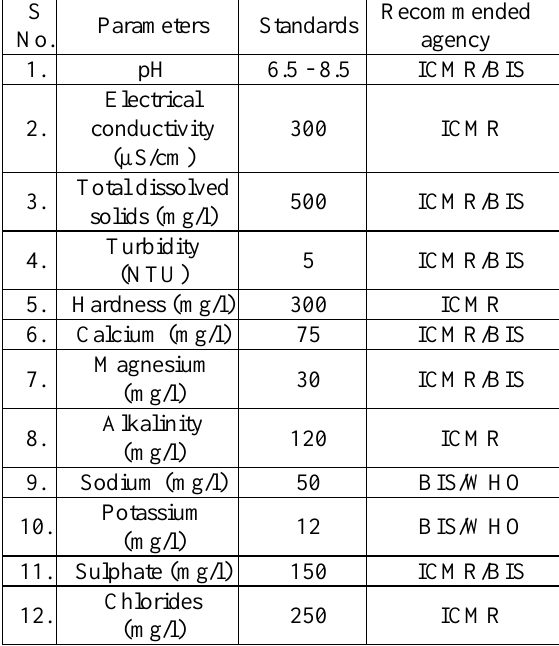
Table 2. Drinking water standards